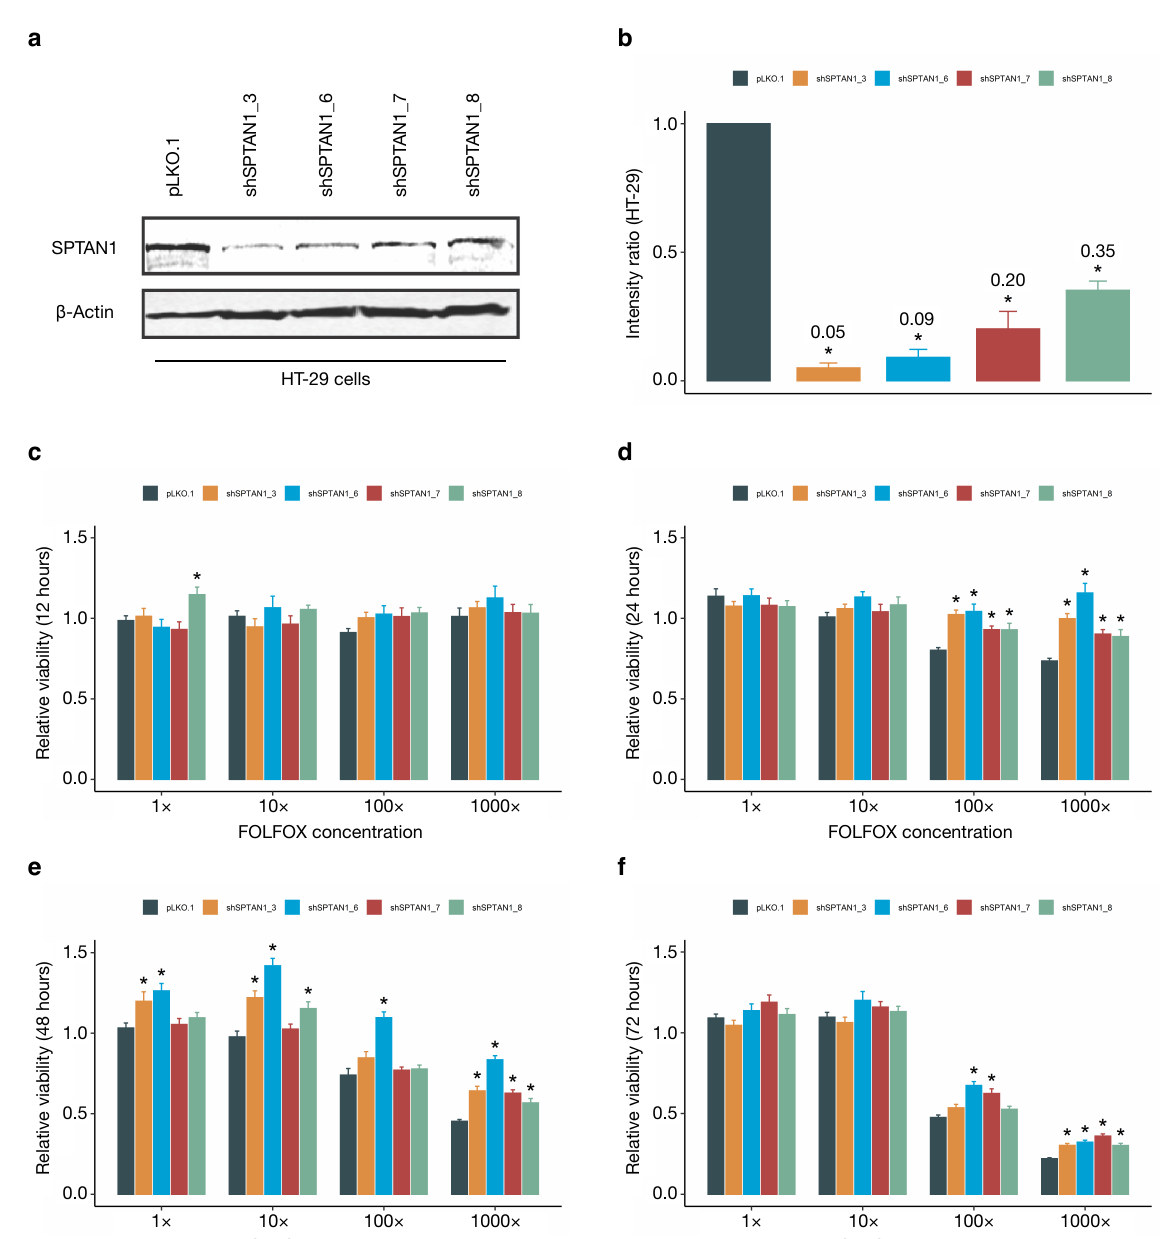
Figure 5. HT-29 cells with SPTAN1 knockdown are less responsive to FOLFOX chemotherapy. Short hairpin RNAs were used to knock down SPTAN1 expression in HT-29 colon cancer cells ( a ). Western blot band intensities were quantified by digital image analysis, to determine SPTAN1 protein levels of knockdown cells relative to control-transduced cells (denoted pLKO.1) ( b ). The uncropped Western blots are shown in Figure S1. Bar charts illustrating the response to FOLFOX chemotherapy in HT-29 colon cancer cells with stable knockdown of SPTAN1 expression ( c – f ). Cell viability in response to incremental doses of FOLFOX chemotherapy was measured by tetrazolium dye (MTT) colorimetric assay after ( c ) 12 h, ( d ) 24 h, ( e ) 48 h, and ( f ) 72 h. Data represent averages from three independent experiments, totalling up to 48 individual absorbance readings for each combination of knockdown strain, timepoint and chemotherapy dose. Absorbance readings of FOLFOX-treated cells were normalised to the average absorbance values of the respective control-treated cells. SPTAN1 knockdown cells and control-transduced cells (denoted pLKO.1) were compared by one-way ANOVA. Differences between individual knockdown strains and the reference group (control-transduced cells) were assessed by Dunnett’s post-hoc test, and denoted with an asterisk (*) if they reached statistical significance. Results with a p -value < 0.05 were considered statistically